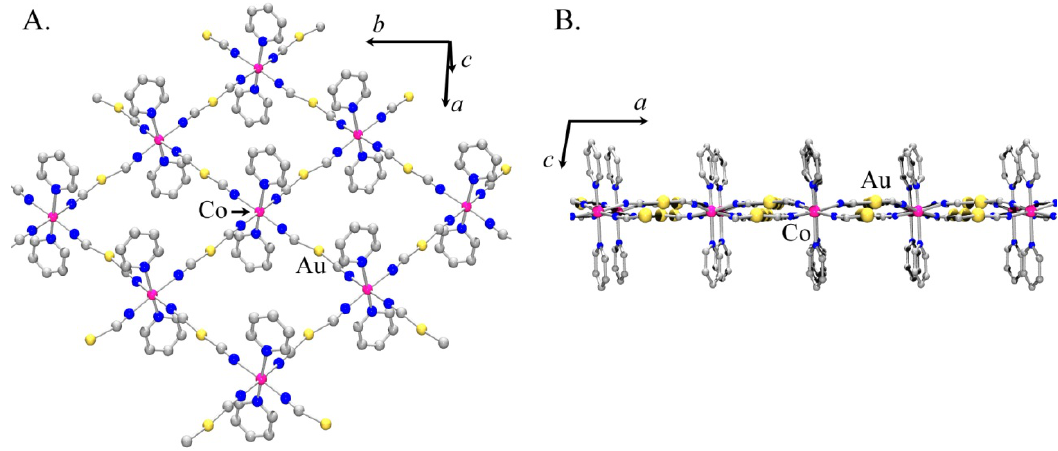
] (pyridine) : ( A ) 2-D square-grid 2 2 2 ] − units with respect to the Co(II) 2